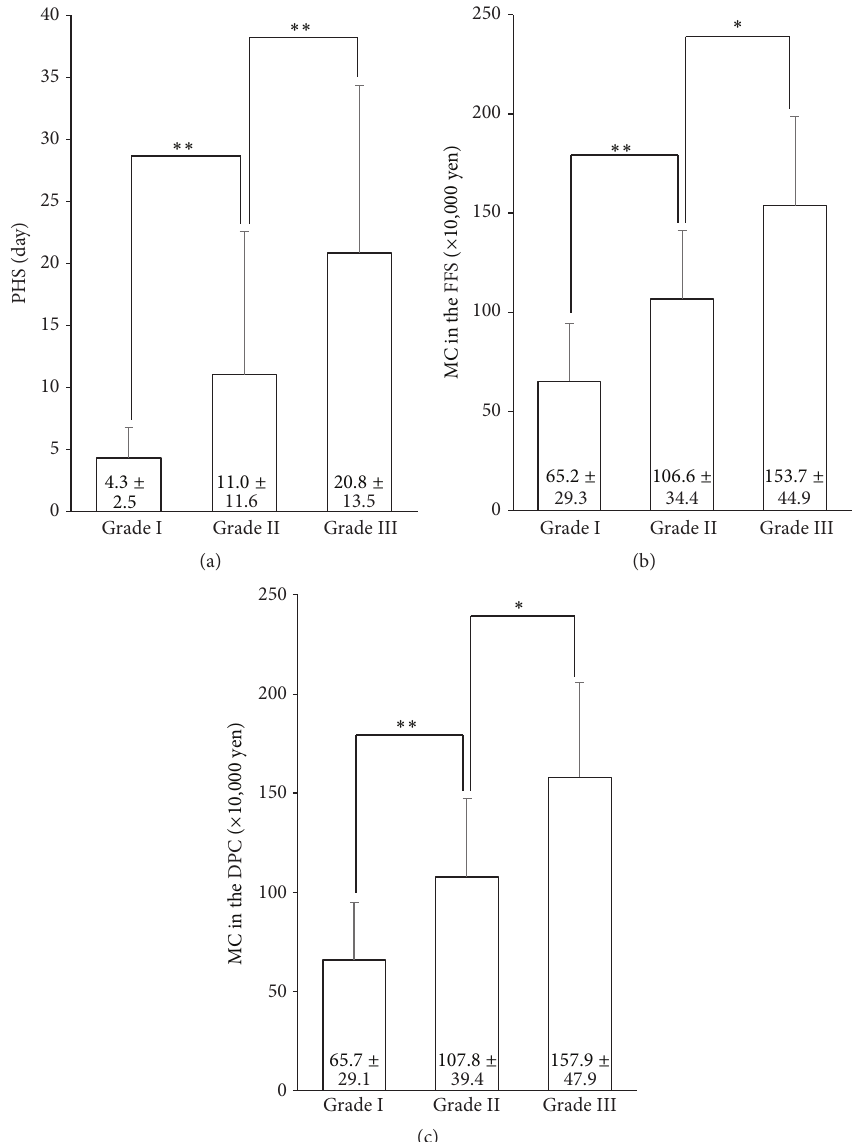
Figure 3: Comparison of PHS and MC according to severity grade ( 𝑛 = 171 ). (a) The differences in the average PHS for each grade. (b) The differences in the average MC in the FFS system for each grade. (c) The differences in the average MC in the DPC system for each grade. PHS: postoperative hospital stay, MC: medical costs, FFS: fee for service, and DPC: diagnosis procedure combination. ∗∗ 𝑃 < 0.01 and ∗ 𝑃 < 0.05